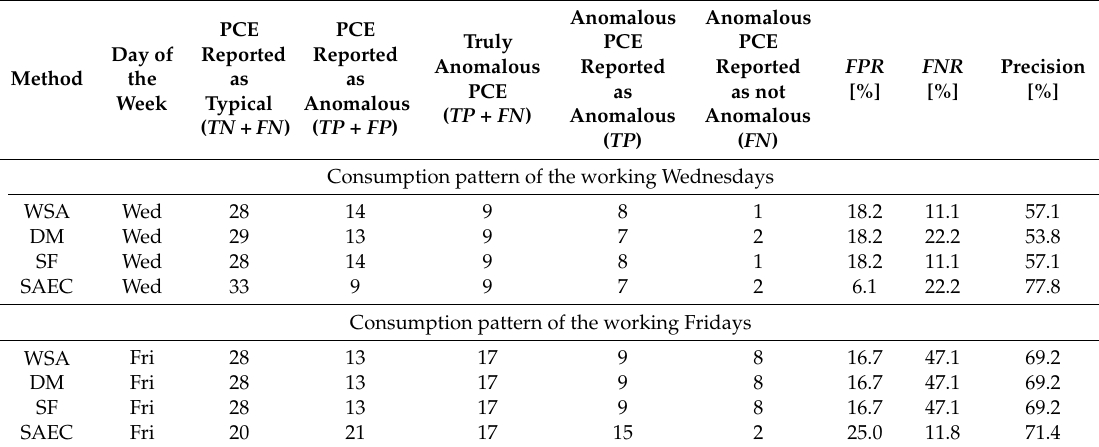
Table 3. Details of the obtained patterns: 5E building Universitat Politècnica de València.